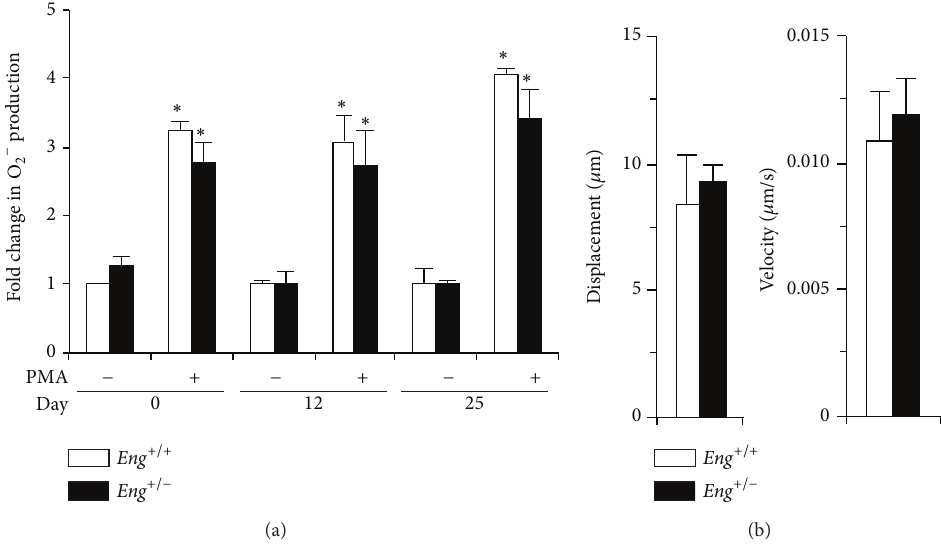
Figure 5: Eng +/− mice show normal bone marrow-derived neutrophil function. (a) Superoxide (O 2− ) production, measured by a dihydroethidium (DHE) based assay, was tested in isolated bone marrow-derived neutrophils from days 0, 12, and 25, with or without PMA stimulation. The results are plotted as fold change relative to the unstimulated Eng +/+ control for each time point. ∗ 𝑃 < 0.05 versus corresponding unstimulated group. (b) Neutrophil migration capacity (displacement and velocity) was determined using fMLP as a chemotactic agent in both Eng +/+ and Eng +/− mice. Results represent mean ± SEM (for DHE assay: 𝑁 = 4 –8 samples for days 0, 12, and 25; for chemotaxis assay: 𝑁 = 3 experiments for each